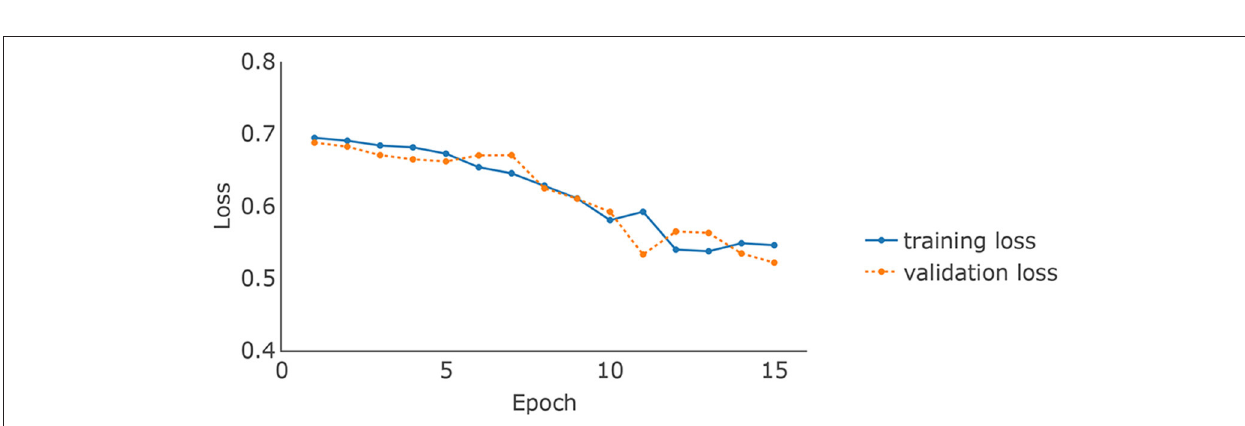
FIGURE 3 | The changes of training and validation losses overtime of